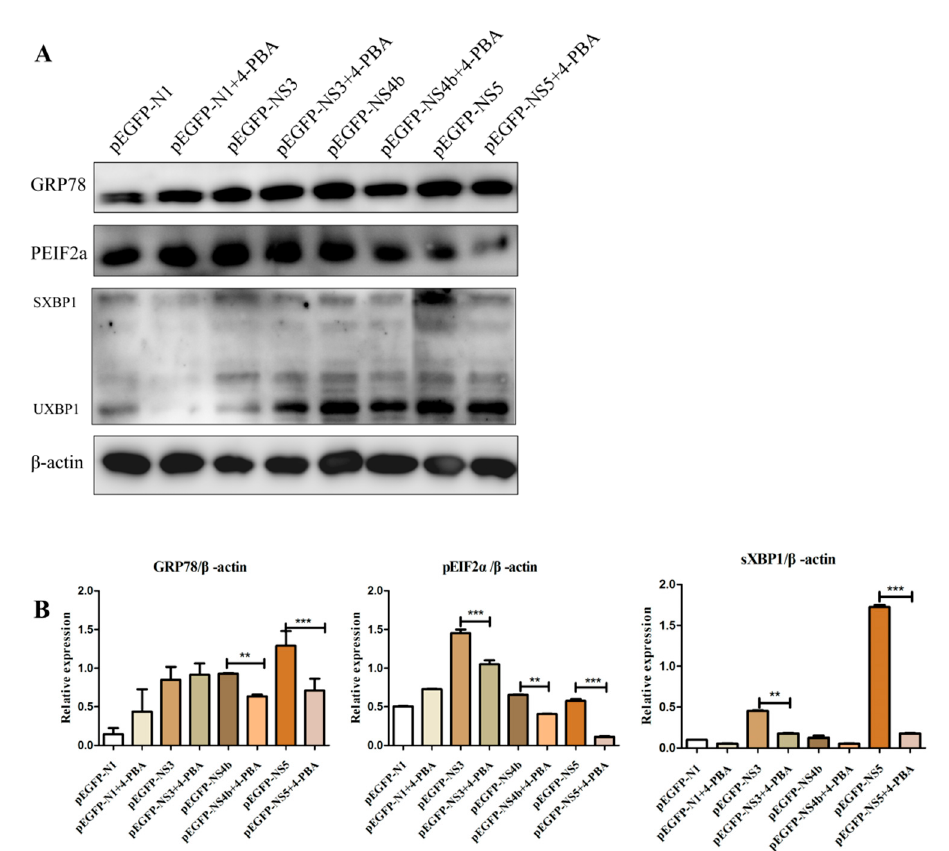
Figure 4. 4-PBA inhibits the fusion protein of JEV to activate the IRE1 and PERK pathways. ( A ) The protein levels of GRP78, pEIF2 α and sXBP1 in BV2 cells incubated with JEV (MOI 1.5) and 4-PBA of 1 mM/mL. ( B ) Densitometry scans of the GRP78, pEIF2 α and sXBP1 brand of western blot from ( A ). ** p < 0.01; *** p < 0.001.